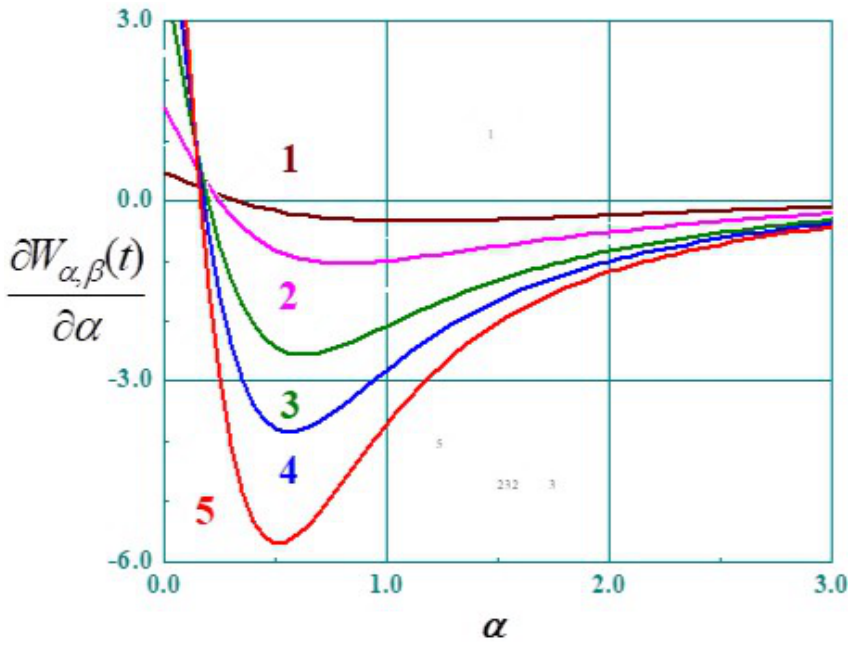
Figure 1. Derivatives of the Wright functions of the first kind with respect to parameter α as a function of α for β = 1 and 1 : t = 0.5; 2 : t = 1.0; 3 : t = 1.5; 4 : t = 1.75; 5 : t = 2.0.